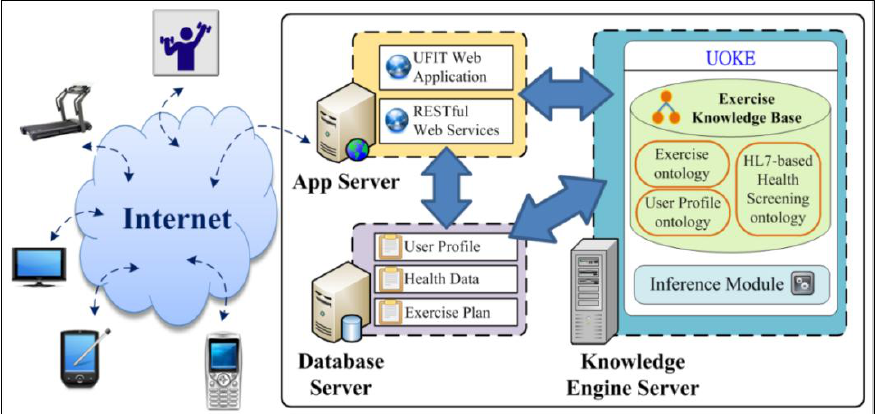
Figure 7. UFIT physical architecture.